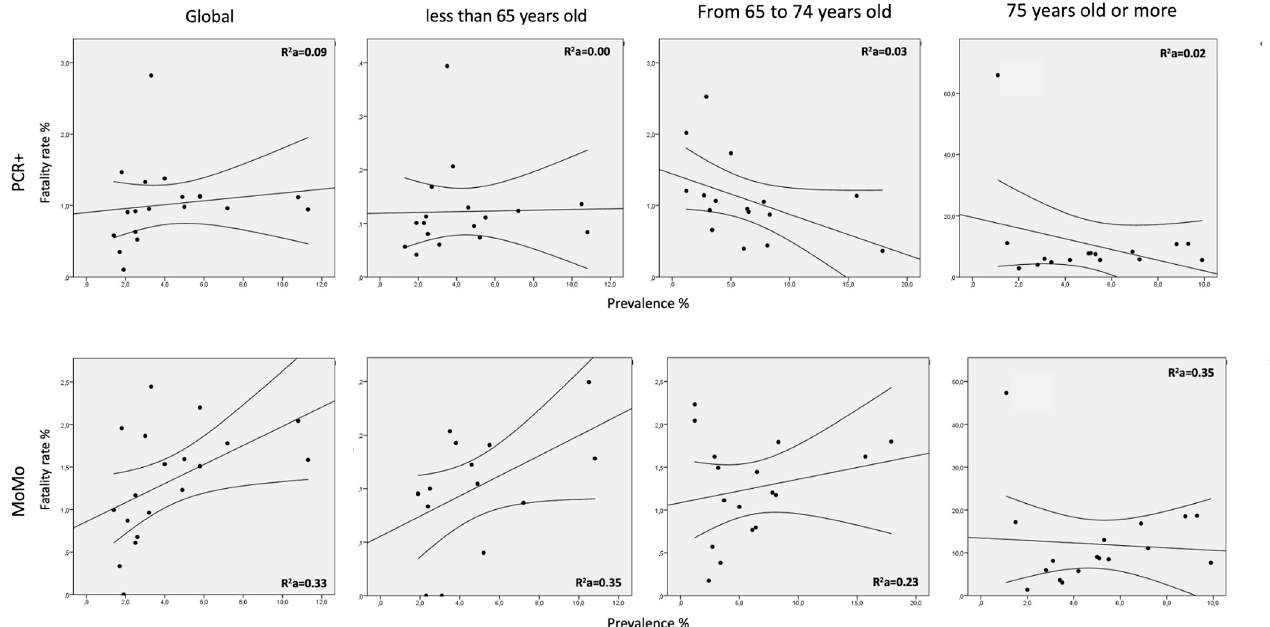
Fig 4. Correlation between prevalence of infection and case fatality rates by age groups calculated for the official number of deaths (PCR+) and the number of deaths by excess mortality (MoMo). The straight line represents the linear regression line, and the curves represent the 95% confidence interval of the regression line.